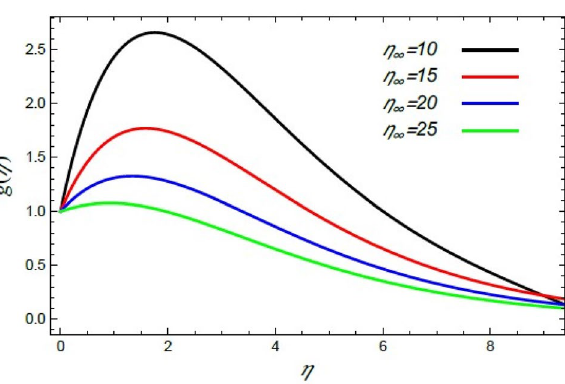
Figure 11. Variation of the azimuthal velocity g (η) versus η as given in Eq. (65) to depict the effect of η